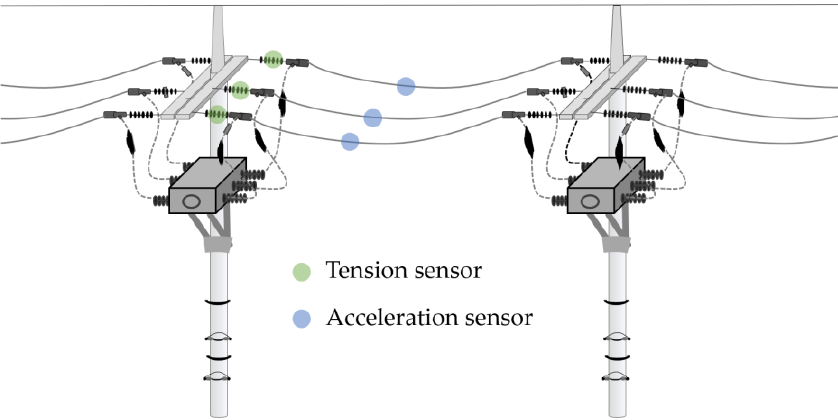
Figure 3. Schematic diagram of the sensor attachment of each sensor.